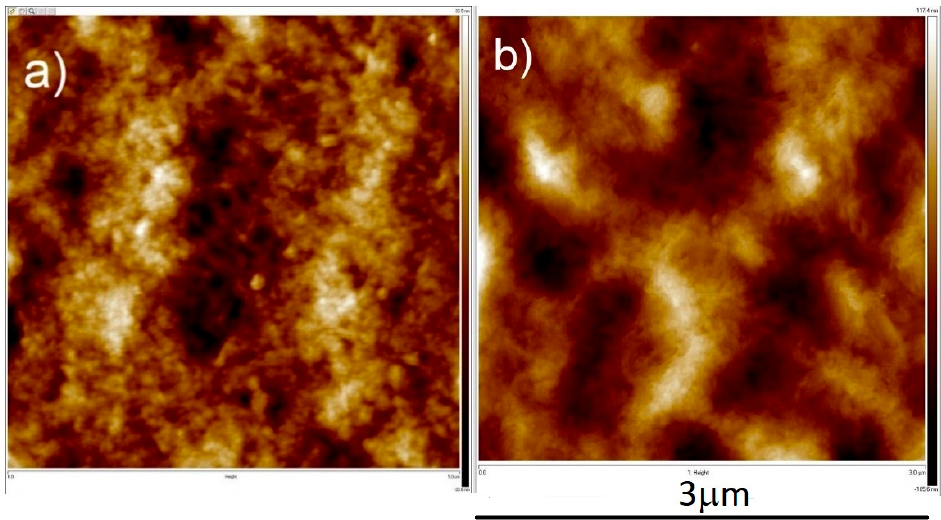
Figure 4. Atomic force microscope (AFM) results of area of 3 × 3 µ m 2 , RMS roughness are ( a ) 9.6 nm for 40 ms:4 ms, and ( b ) 32.8 nm for 40 ms:20 ms.